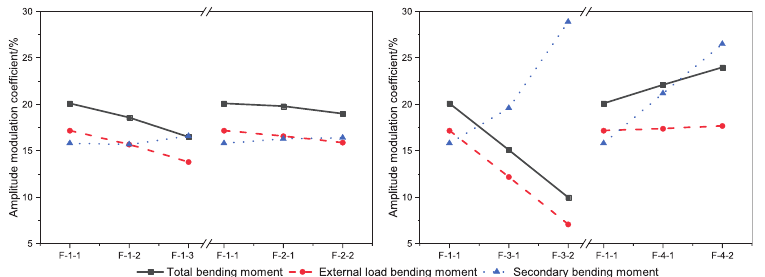
Figure 12. The moment modulation coefficient of the bearing section under ultimate load